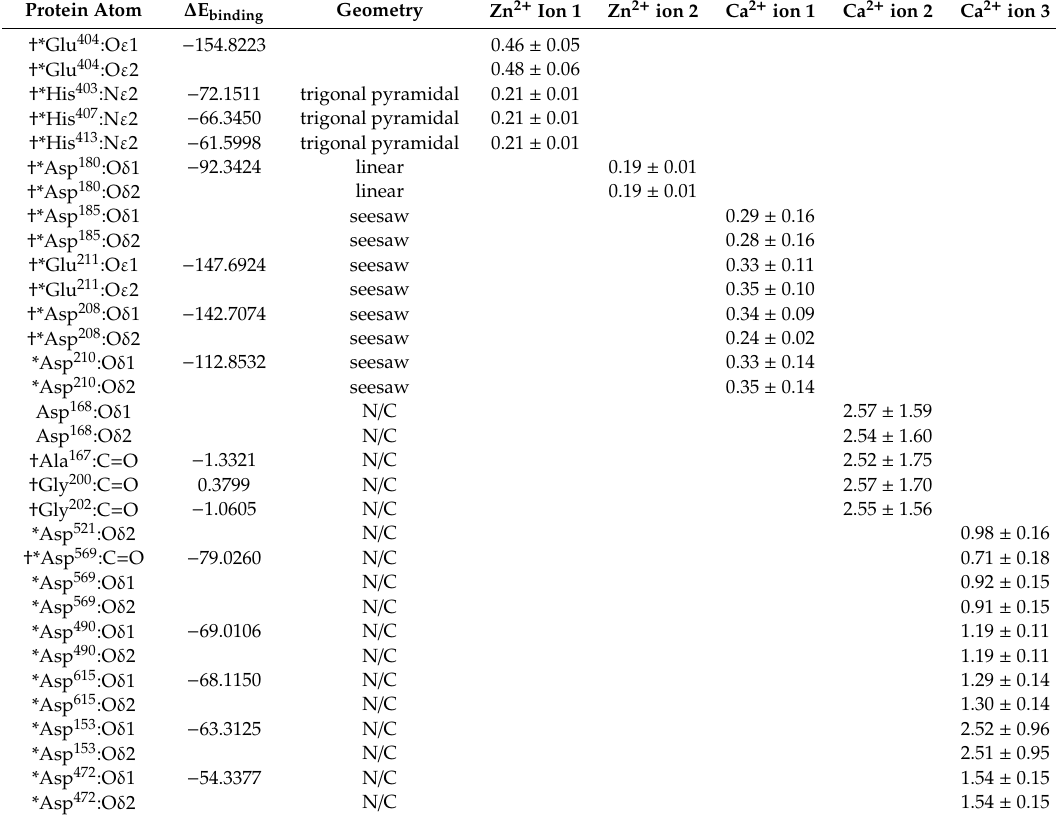
Table 6. Distances of ions to the interacting protein residue atoms identified from the 1CK7 X-ray crystal. Statistically significant protein residue atoms as identified by outlier analysis with the associated per residue interaction energies and binding geometry. 1CK7 identified interactions are marked with a dagger ( † ); statistically significant interactions are marked with an asterisk (*); and binding geometries were determined for those atoms within 0.35 nm. Distance is given in nm and energies in kJ mol − 1 a,b,c . Protein Atom ∆ E binding Geometry Zn 2 + Ion 1 Zn 2 + ion